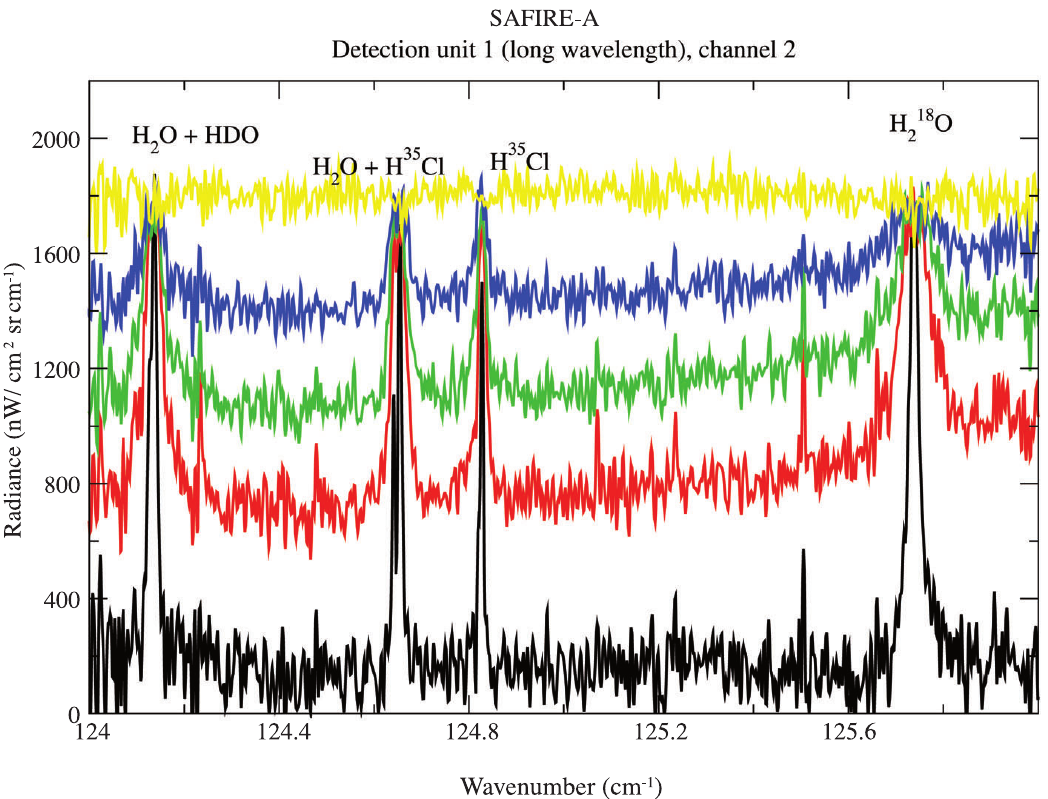
Fig. 15. Limb-scanning sequence of atmospheric emission spectra acquired in the 124-126 cm –1 window. Spectral features due to interesting molecular species are evidenced by vertical lines. Atmospheric opacity due to water vapour absorption limits analysis to upper atmospheric layers, so only limb scanning angles corresponding to upper layers are